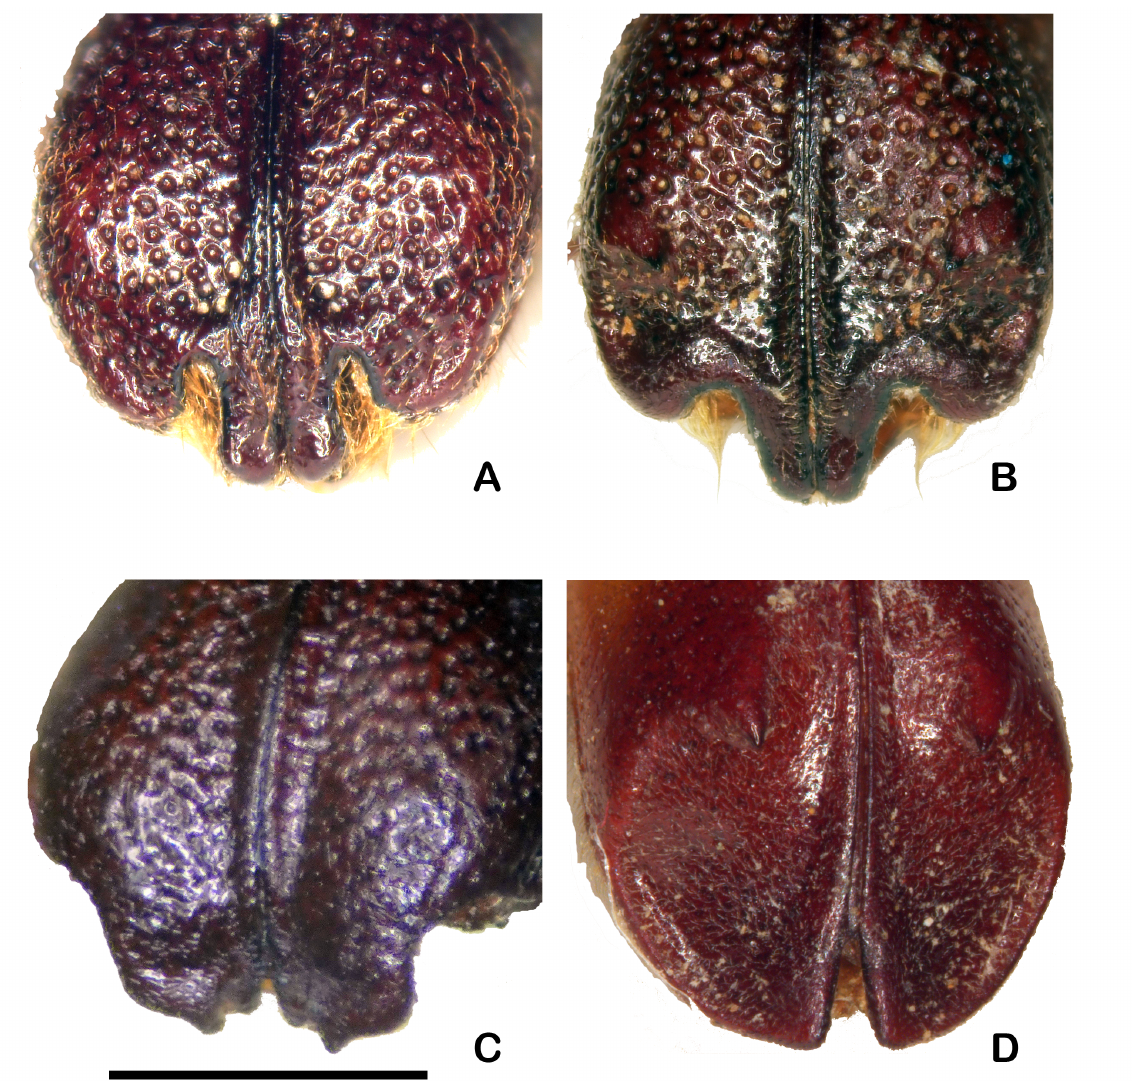
Fig. 3. Declivity of the females of species of Xylopertha Guérin-Méneville, 1845. A . Xylopertha retusa (Olivier, 1790). B . X. praeusta (Germar, 1817). C . X. elegans sp. nov. D . X. reflexicauda (Lesne, 1937). Scale bar = 1